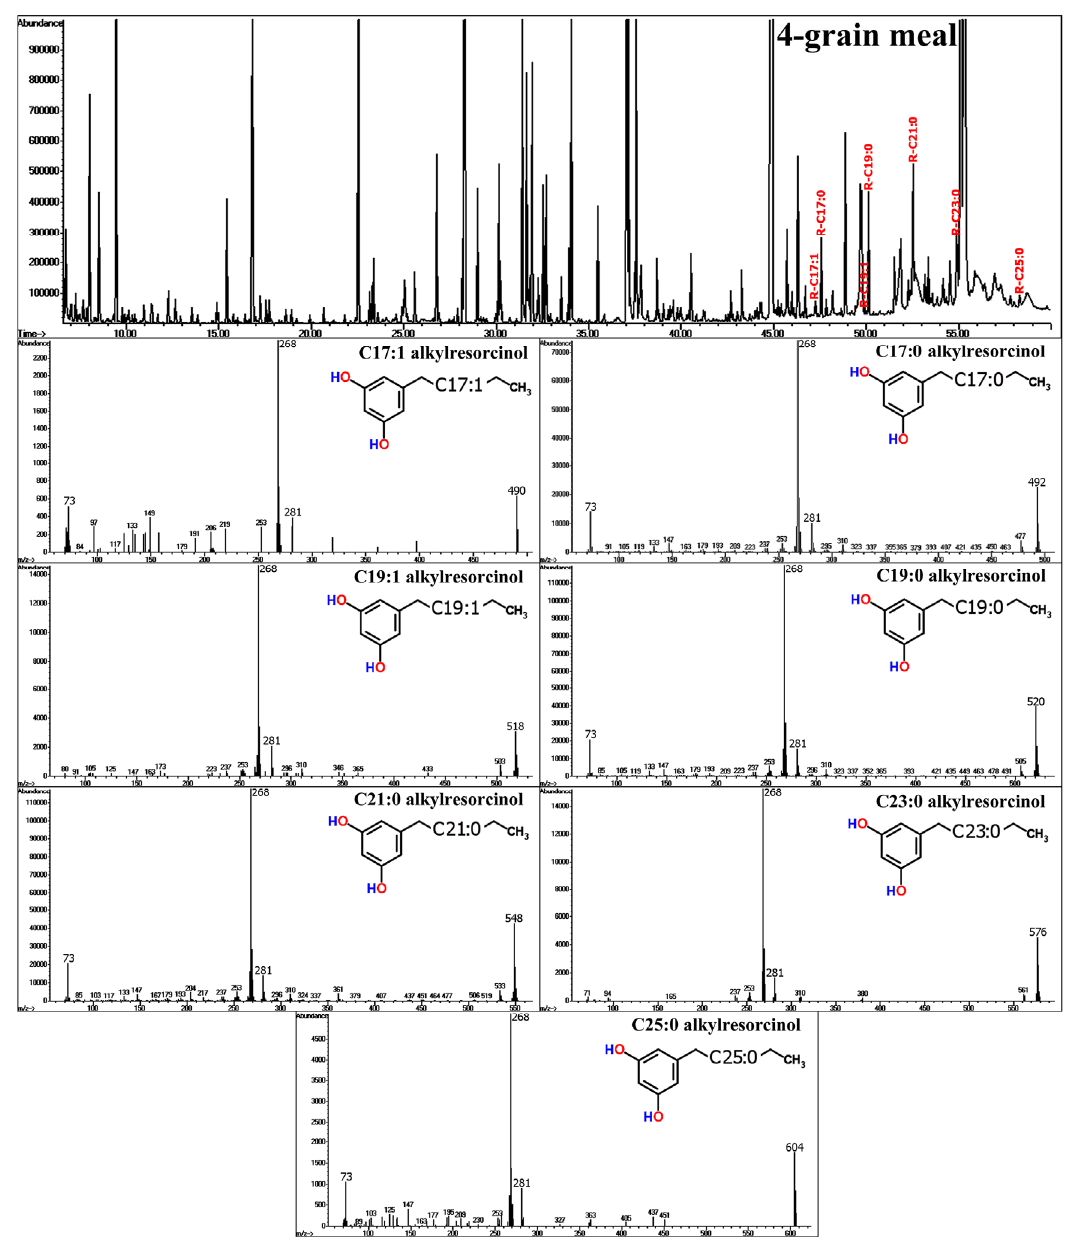
Figure 12. In the GC-MS chromatogram of four-grain meal, commonly occurring alkylresorcinols are indicated. The corresponding MS spectra of C17- to C25- alkylresorcinols are depicted